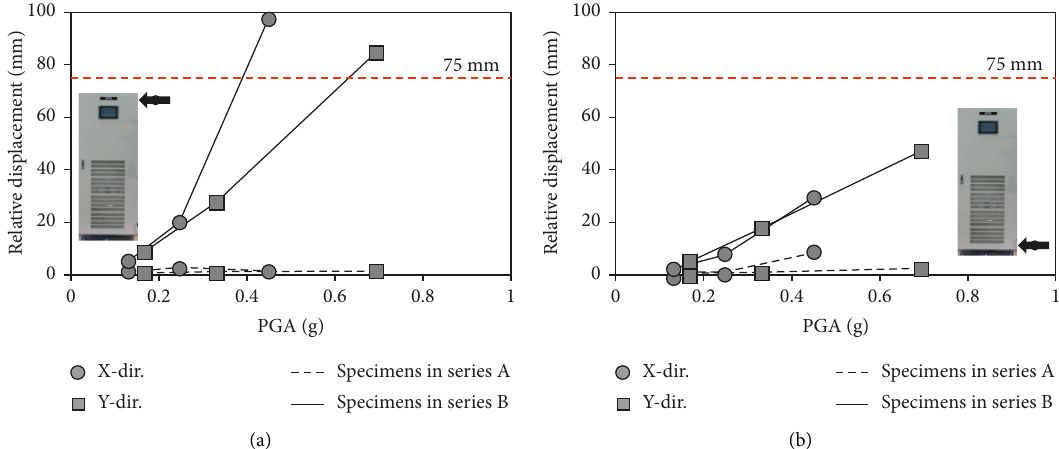
Figure 17: Maximum relative displacement response versus PGA for the test specimens in Series A and B. (a) At the top of the UPS. (b) At the bottom of the UPS.